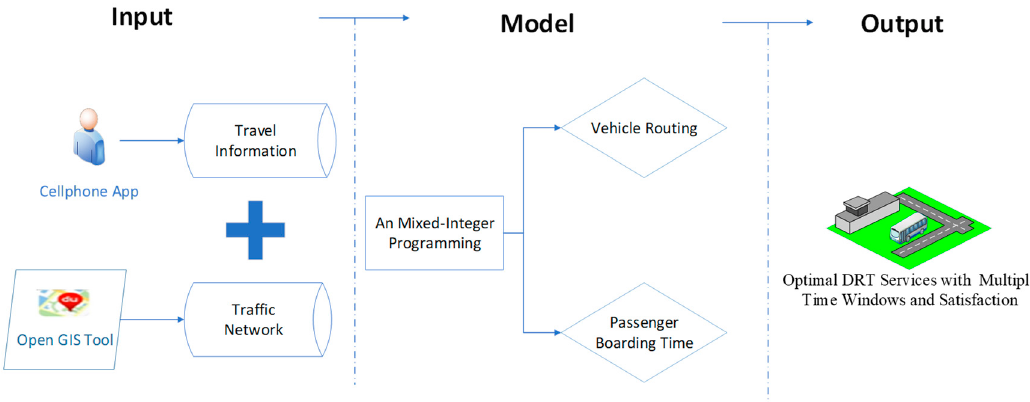
Figure 1. Research Framework.